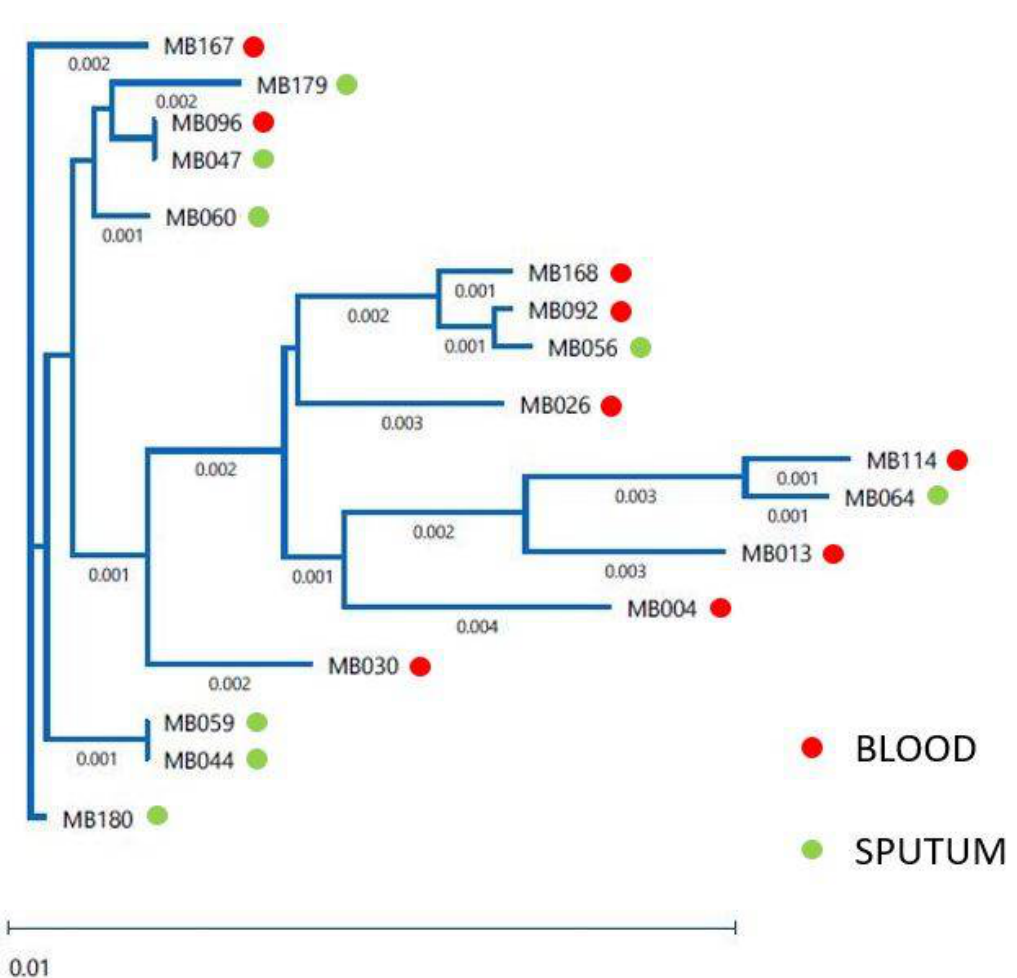
Figure 1. MLST-based dendrogram of 17 C. albicans clinical isolates (MB004-MB180) recovered from blood and sputum of COVID-19 patients.